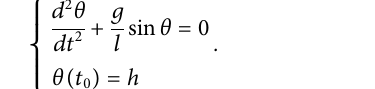
Supplementary Figure S1 ; Supplementary Presentation S3